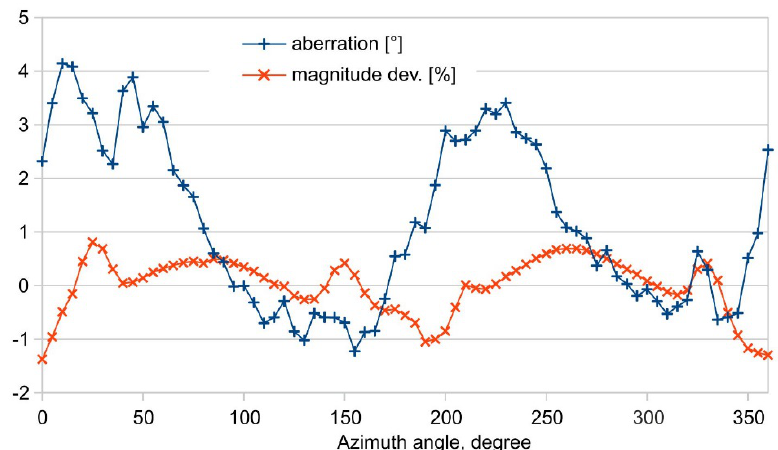
Figure 16. Measured relative magnitude variation (in percentage) and aberration (in degrees) related to the directional characteristic of Figure 14.